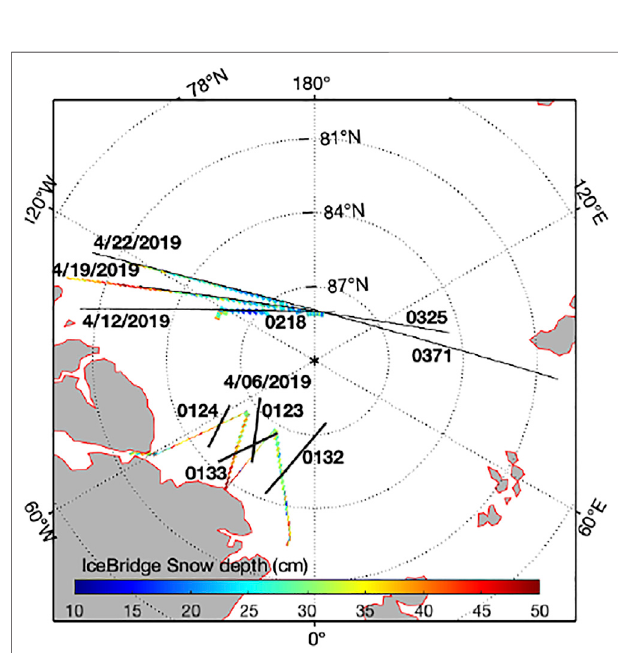
FIGURE 3 | The ICESat-2 (black lines labeled with 4 digital numbers indicating the reference ground tracks, RGTs) and IceBridge (colored curves) ground tracks in April 2019 over Arctic sea ice. The color bar represents the IceBridge snow depth in cm.